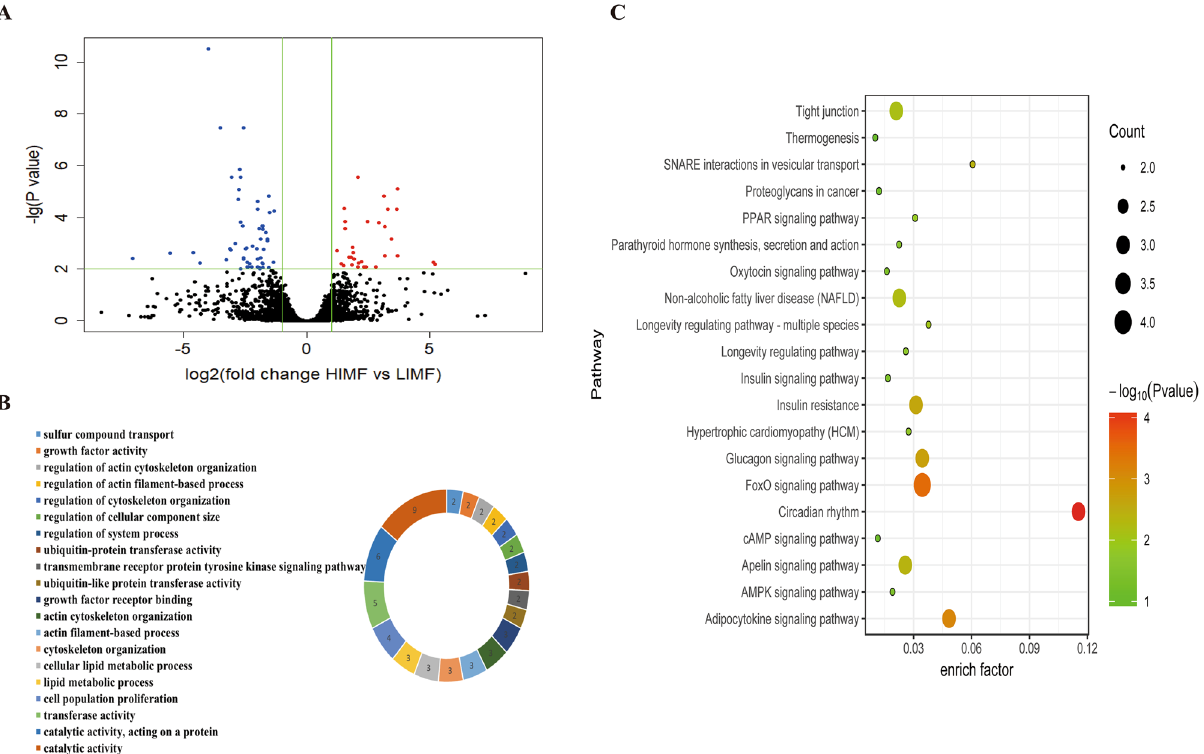
Figure 3. Identification and functional analysis of DEGs in the IMF group. ( A ) Volcano plot of DEGs from LD muscle samples. The abscissa indicates log 2 fold change, the ordinate indicates -lg (FDR) values, red dots indicate differential expression of upregulated genes, blue dots indicate differential expression of downregulated genes, and black dots indicate no differential expression. ( B ) GO enrichment analysis of DEGs between the HIMF and LIMF groups. ( C ) KEGG enrichment analysis of DEGs. The enrich factor is the ratio of DEGs annotated in a pathway term to the total genes annotated in the same pathway term. Smaller P -values indicate higher